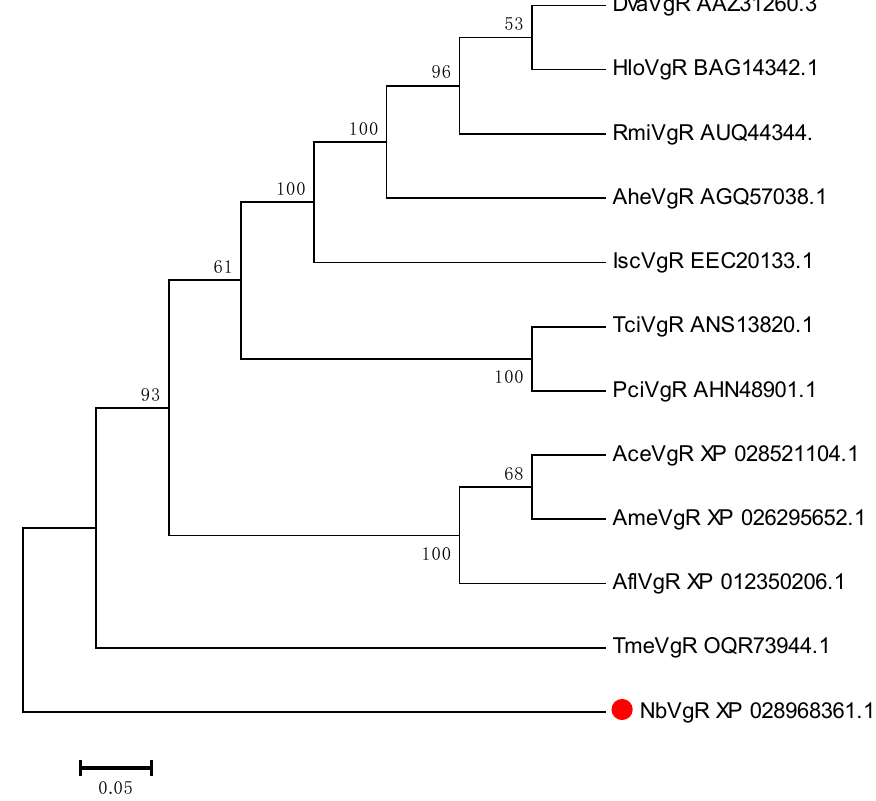
Figure 8. Phylogenetic tree for the VgR in N. barkeri constructed using the neighbor-joining method in MEGA software (version: 7.0). Each branch shows bootstrap values from 1000 replications. Table S4 lists the Vgs sequences used in this analysis.